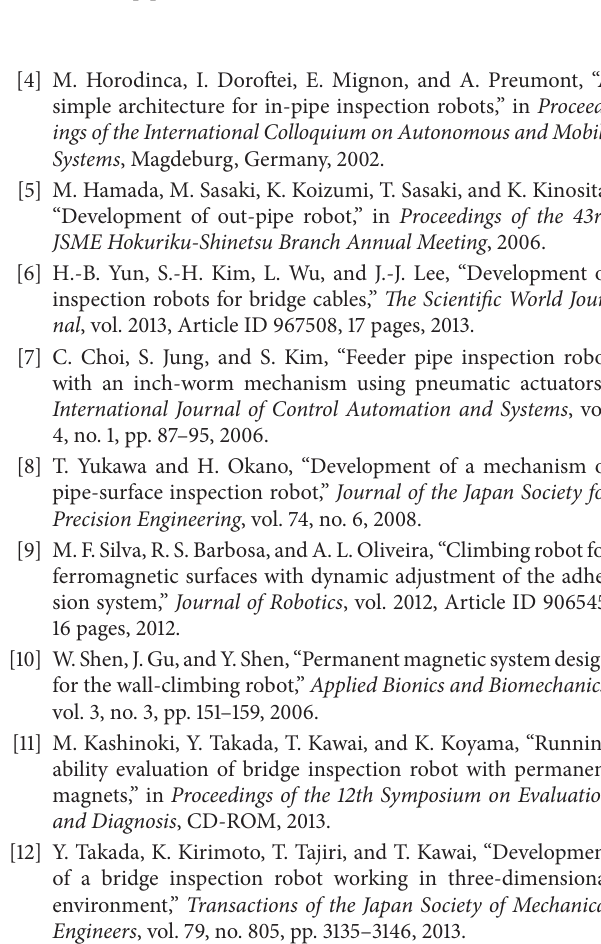
Figure 14: Attitude of robot on steel pipe.